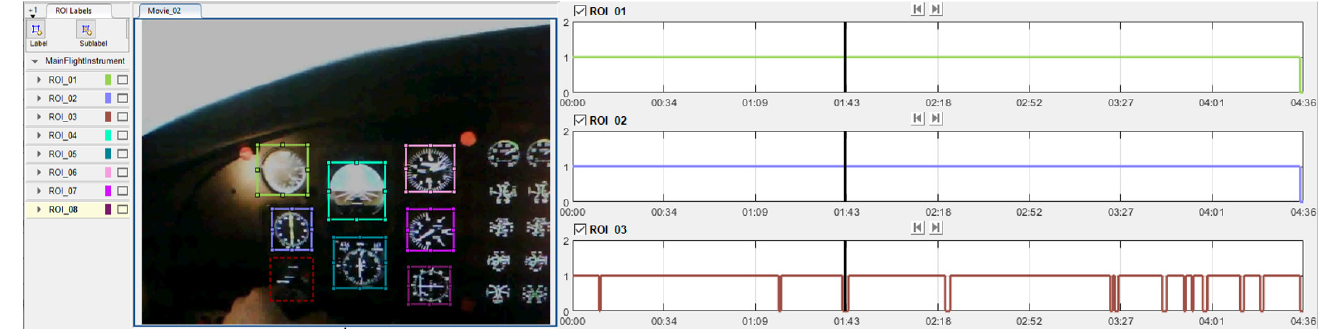
Figure 4. Example video recording showing the loss of ROI3 when the operator performs hand movements—the lost ROI is marked with a dashed line.